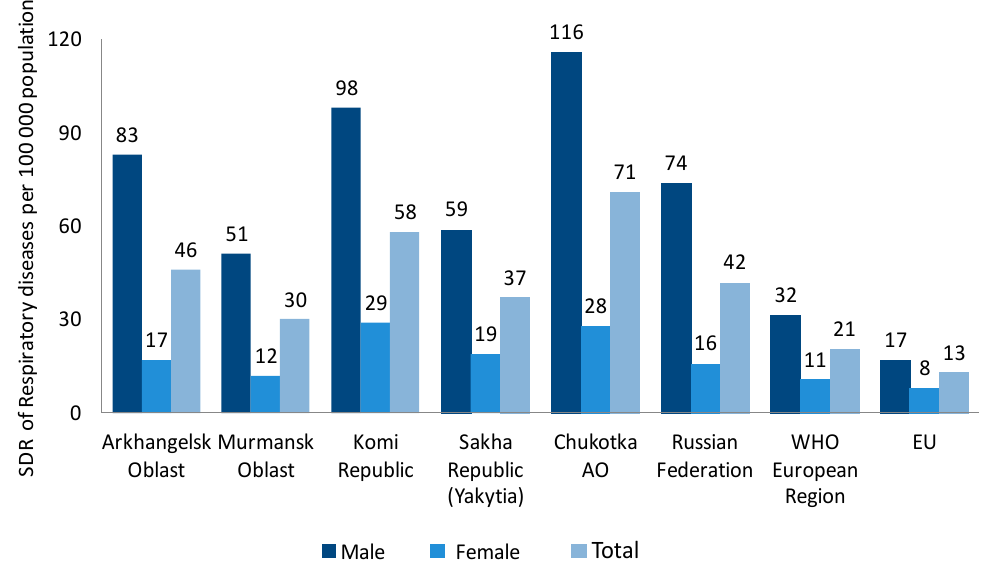
Figure 1. Standardized death rates (SDR) of respiratory diseases per 100,000 population in selected regions of the Russian North.